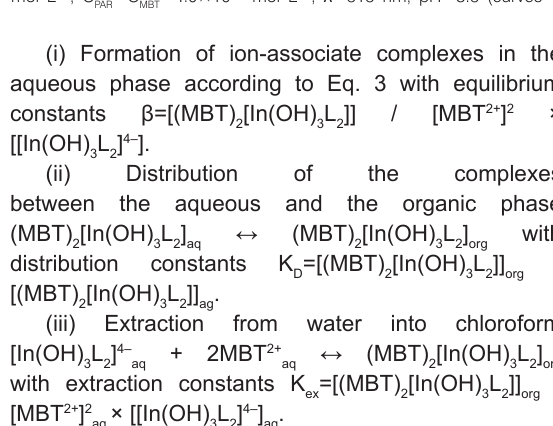
=C =4.0×10 −4 mol L −1 , λ =515 nm, pH=8.5 (curves 1 PAR MBT